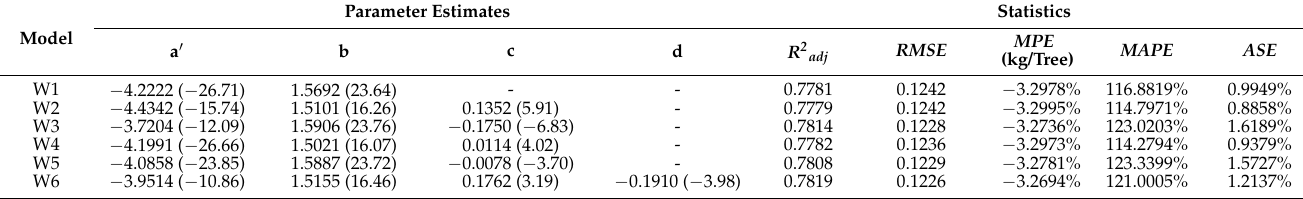
Table 3. Fitting parameter estimates and statistics for log-transformed regression model of shoot sheath biomass. Model